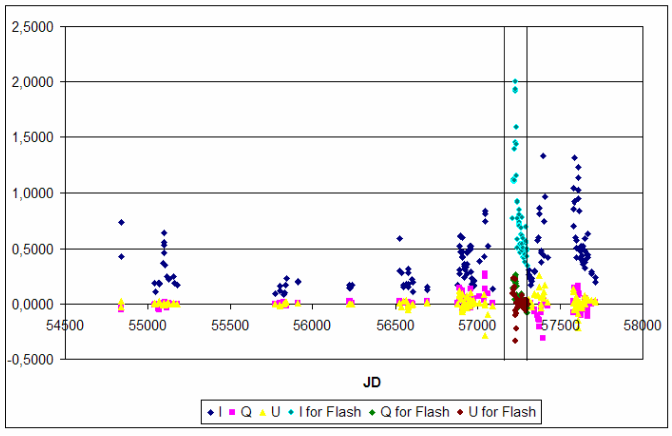
Figure 10. Absolute Stokes parameters behaviour at the third period (the flash is